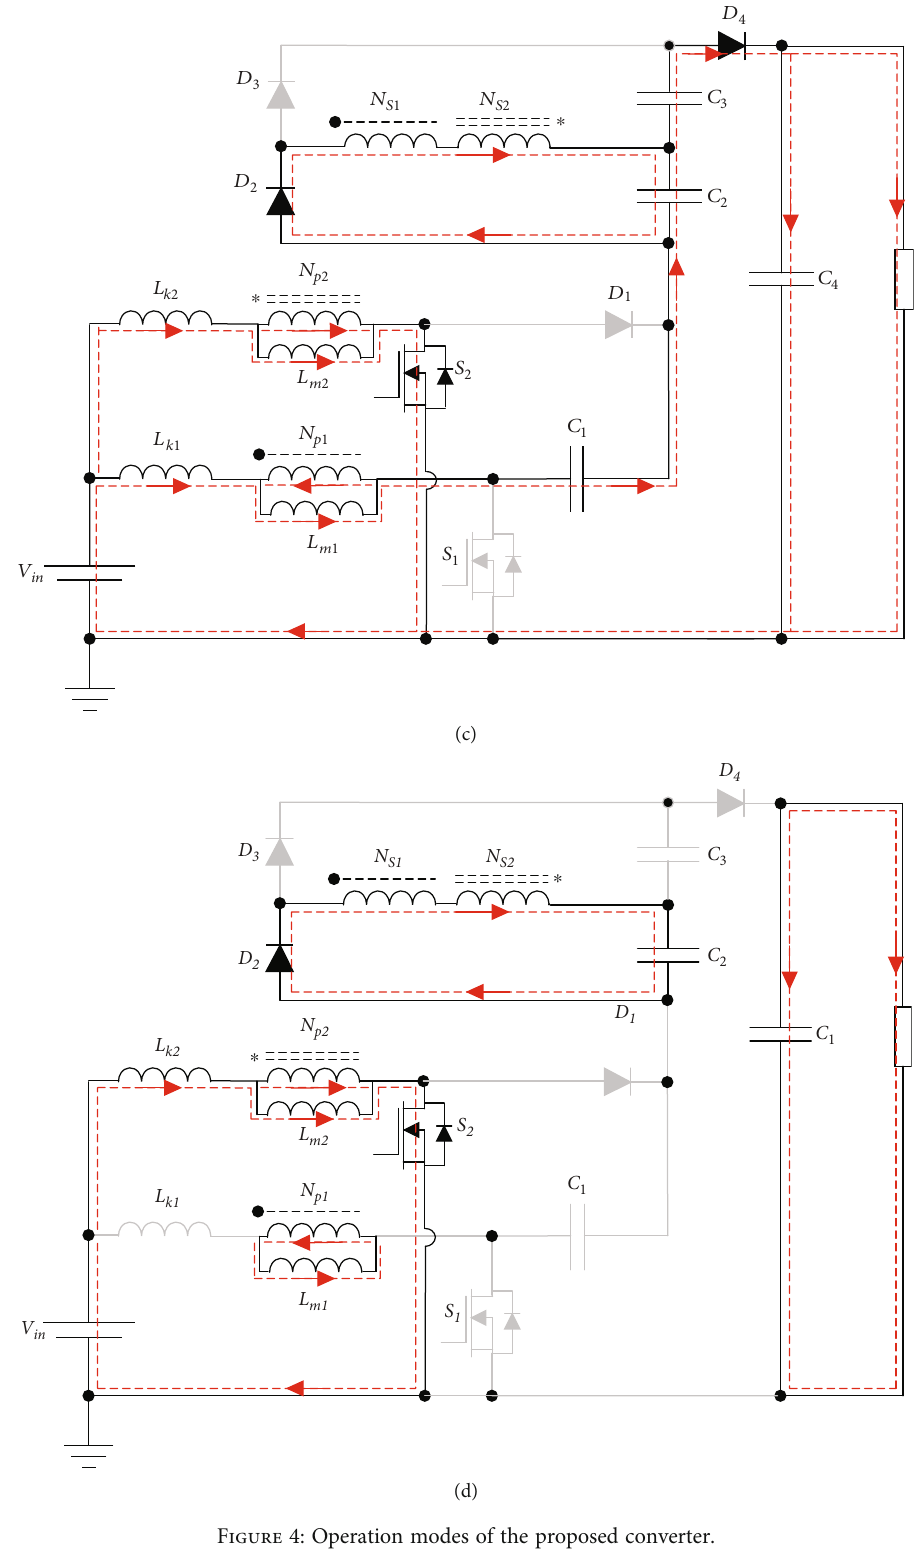
Figure 4: Operation modes of the proposed